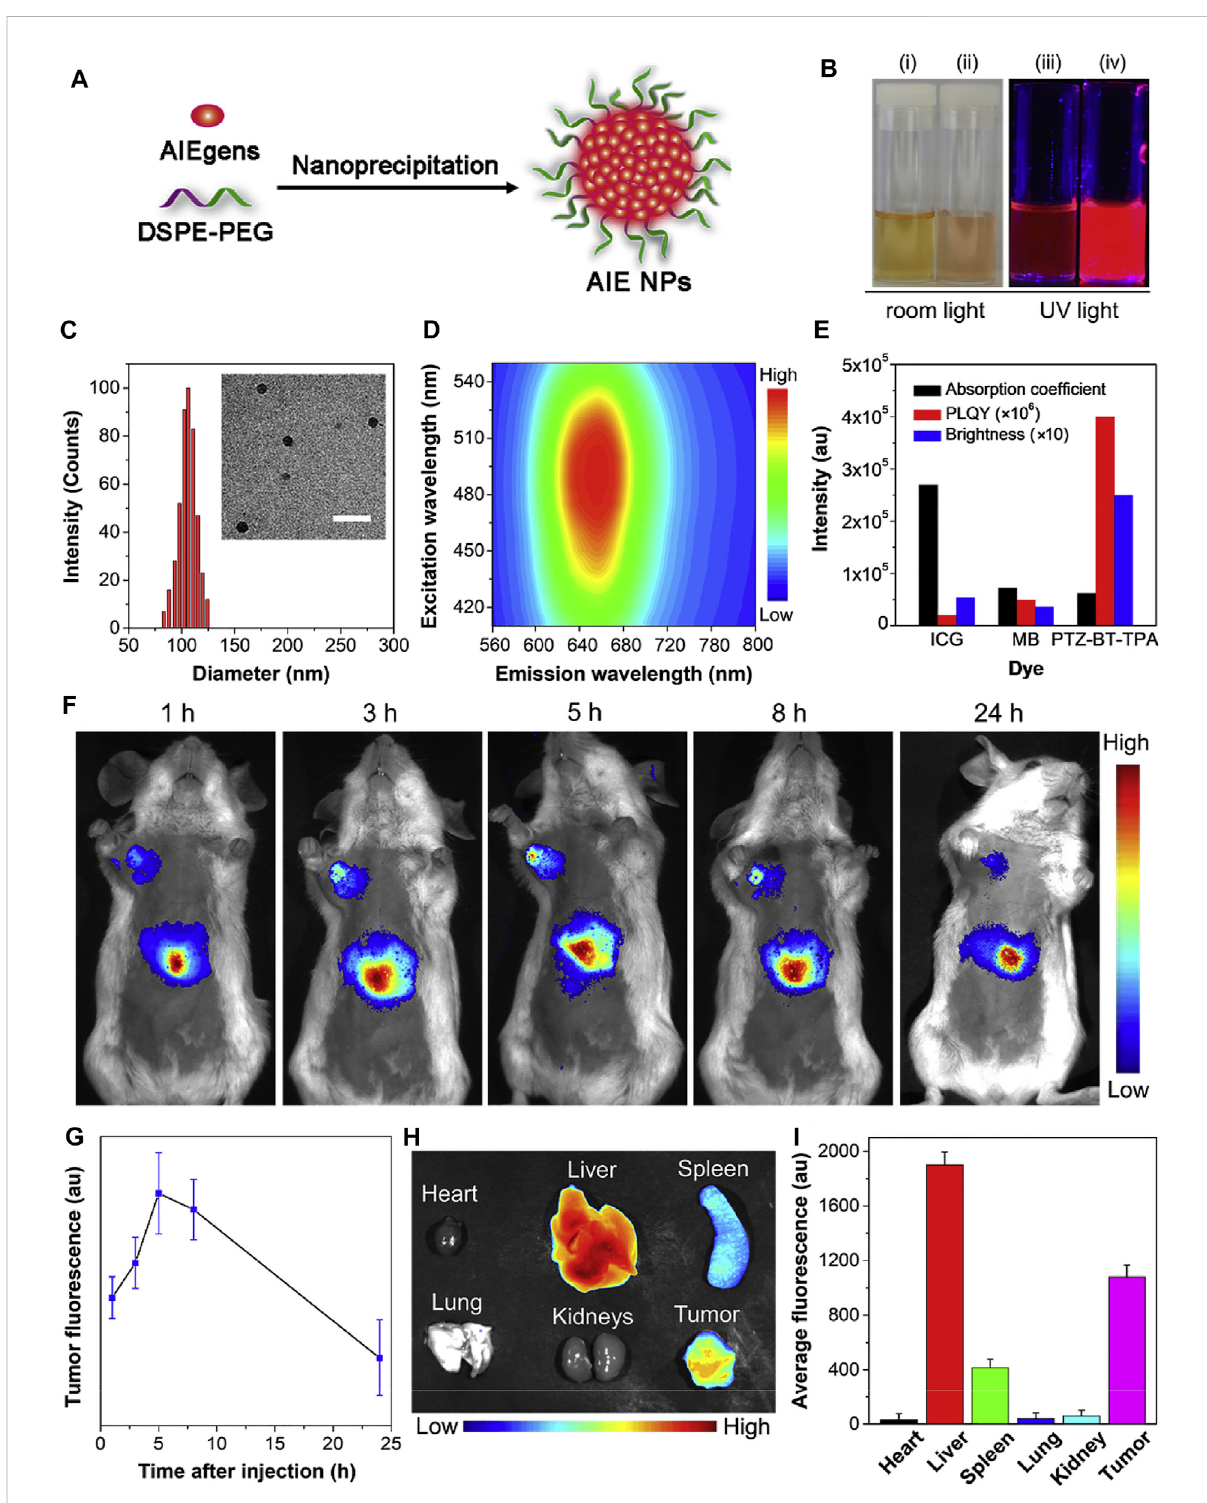
FIGURE 17 (A) Schematic illustration of the preparation of AIE-NPs through a nanoprecipitation method. (B) Photographs of PTZ-BT-TPA (i, iii) in THF and (ii, iv) as NPs under room and UV light (365 nm), respectively. (C) Representative DLS pro fi le and TEM image of the AIE-NPs. Scale bar = 300 nm. (D) PhotoluminescenceexcitationmappingoftheAIE-NPs. (E) Comparisonoftheabsorption coef fi cient,PLQY andbrightnessofICG,MBandPTZ-BT- TPAinwater. (F) Invivo fl uorescenceimagingoftumor-bearingmiceand (G) thecorresponding fl uorescenceintensityoftumorsiteatdifferent time intervals after intravenous injection of the AIE-NPs. Data are presented as the means ± SD ( n = 3). (H) Ex vivo fl uorescence image and (I) fl uorescence intensity of main organs (heart, liver, spleen, lung, and kidneys) and tumor after intravenous administration of AIE-NPs for 24